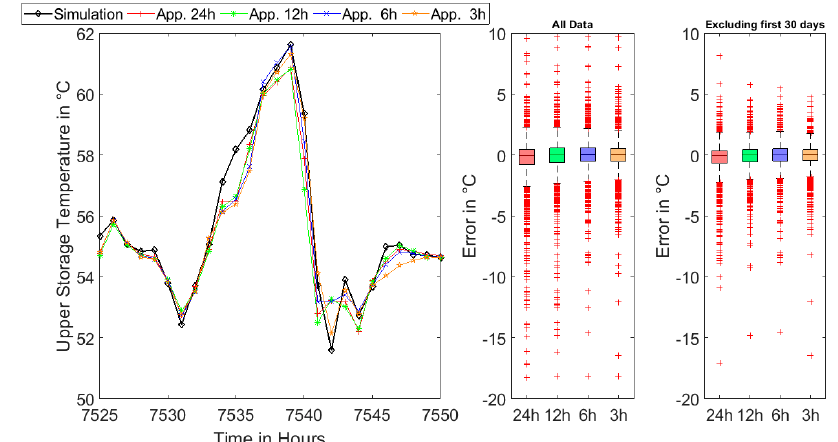
Figure 6. Left: Simulated and predicted upper storage temperature (T4) for one day on the basis of different prediction horizons (if < 24 h, then one after the other; time steps = 1 h), Right: Distribution of the absolute error of these temperature predictions over the period of one year for the relevant temperatures below 60 °C with and without learning phase.